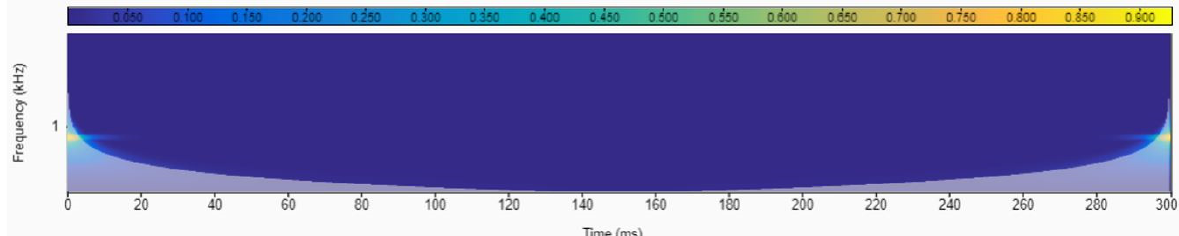
Figure 5. Scalogram of the AE signal during one grinding pass (Test No.2).